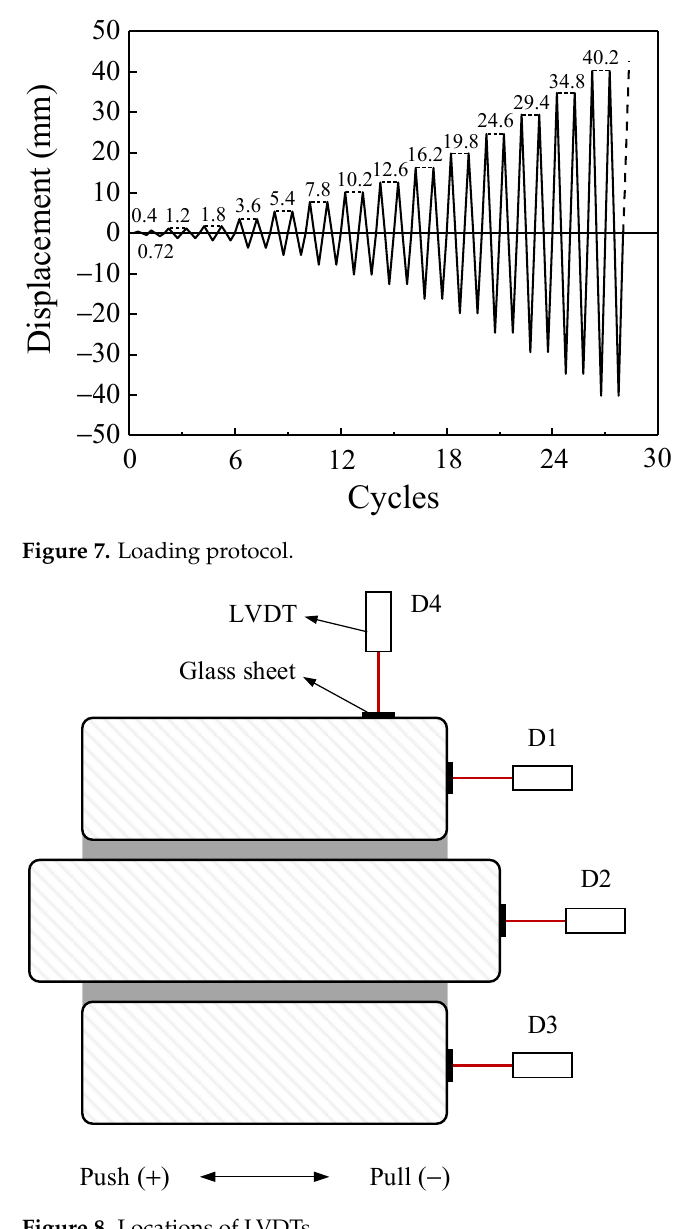
Figure 8. Locations of LVDTs.